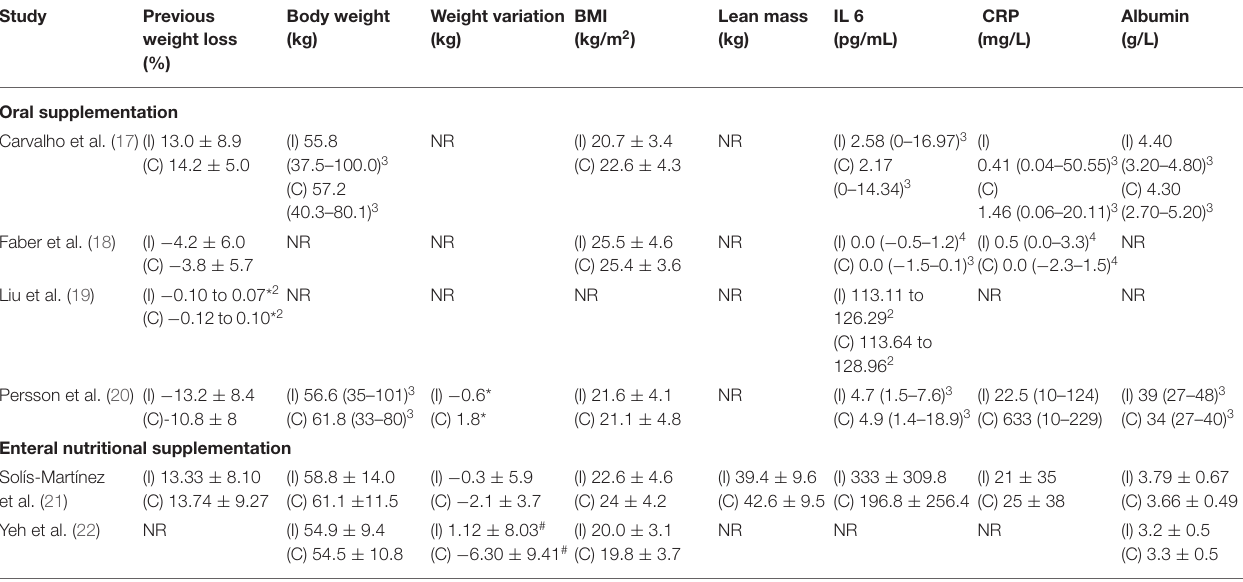
TABLE 3 | Baseline characteristics of the subjects from studies included in the meta-analysis.